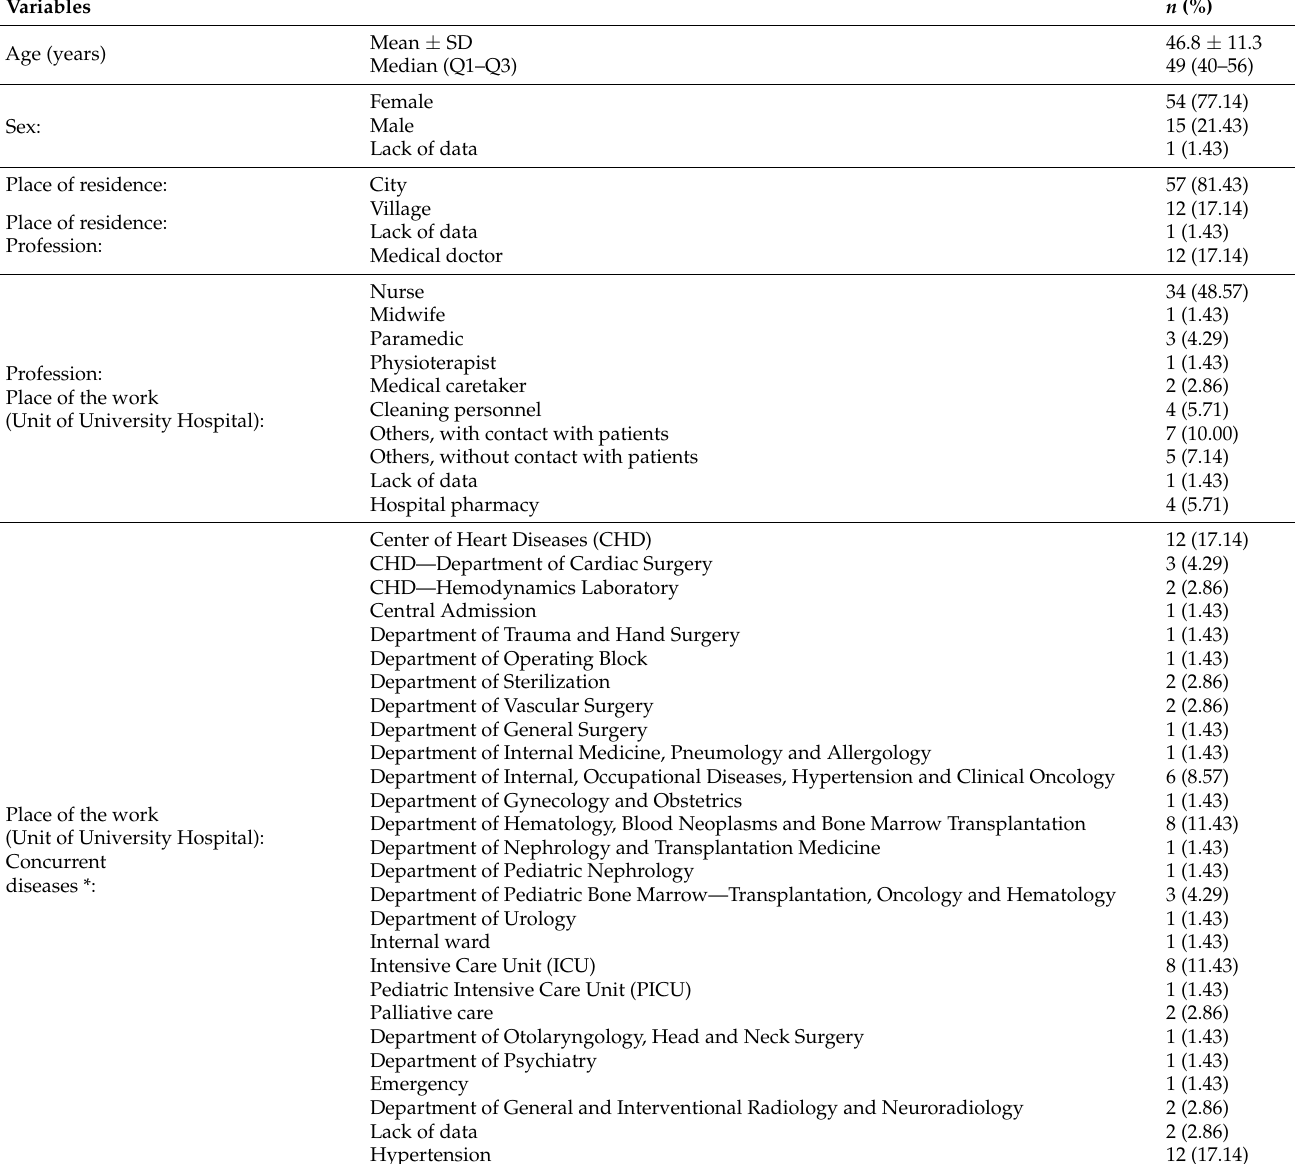
Table 3. Demographic, occupational, and clinical characteristics of study group ( n =